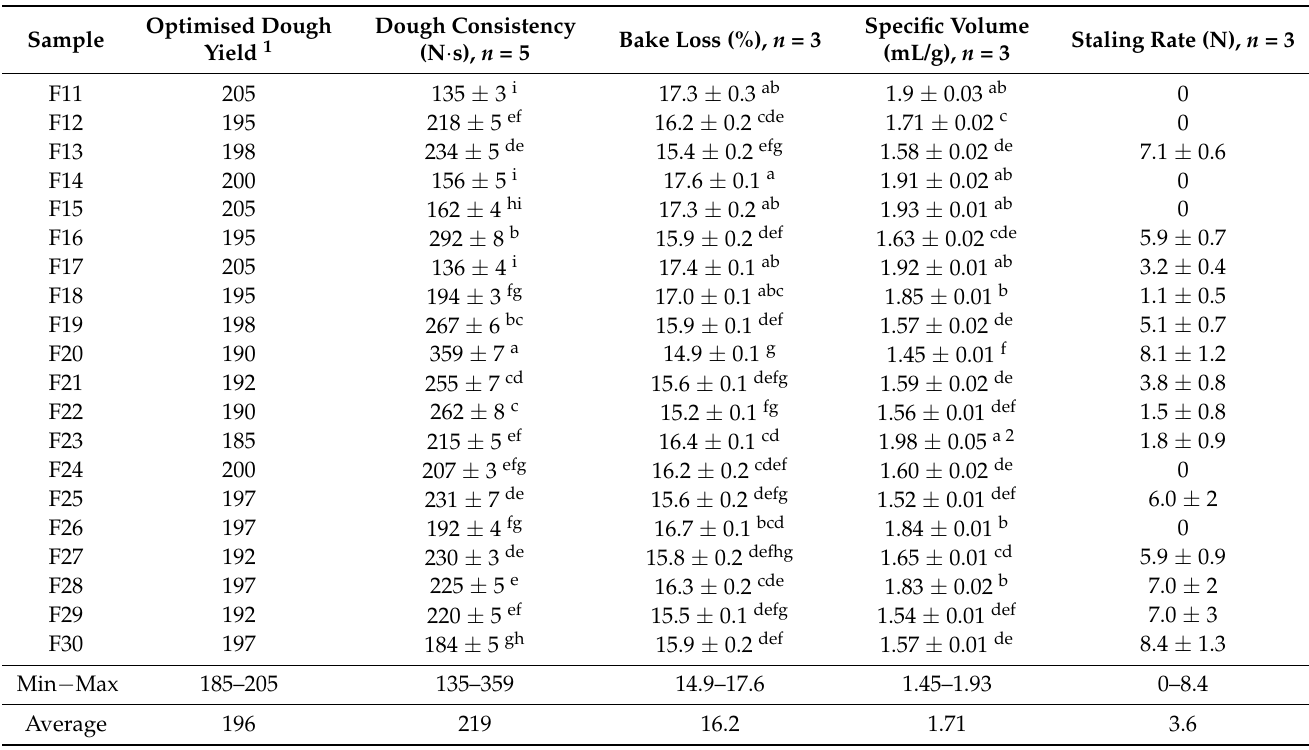
Table 2. Optimised dough yields and dough consistencies, bake losses, specific volumes, and staling rates of the oat bread samples ( n =